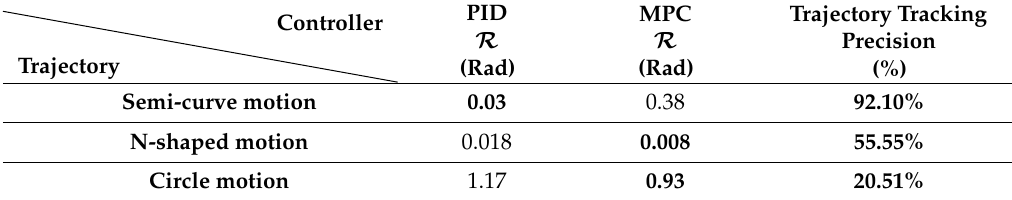
Table 10. Trajectory tracking precision parameter related to the three trajectories.